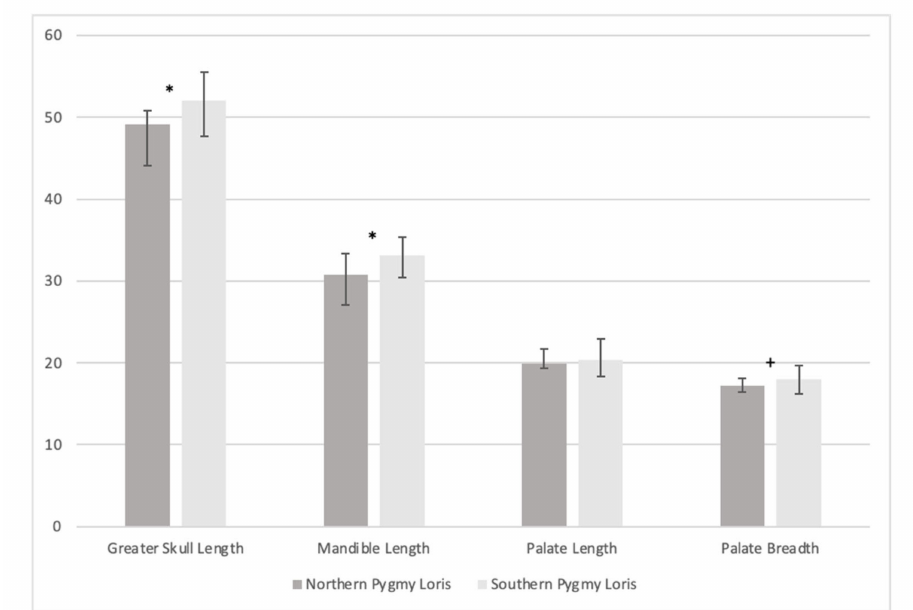
Figure 5. Plot of mean craniometric distances (mm) of adult northern and southern pygmy loris specimens across four measures, showing a significant difference (*) between northern and southern specimens for greater skull length ( t = 2.3361, df = 19, p = 0.0306), mandible length ( t = 2.79948, df = 20, p = 0.0112), and a near significant difference (+) for palate breadth ( t = 2.0736, df = 21, p = 0.0506). Error bars represent the minimum and maximum distances